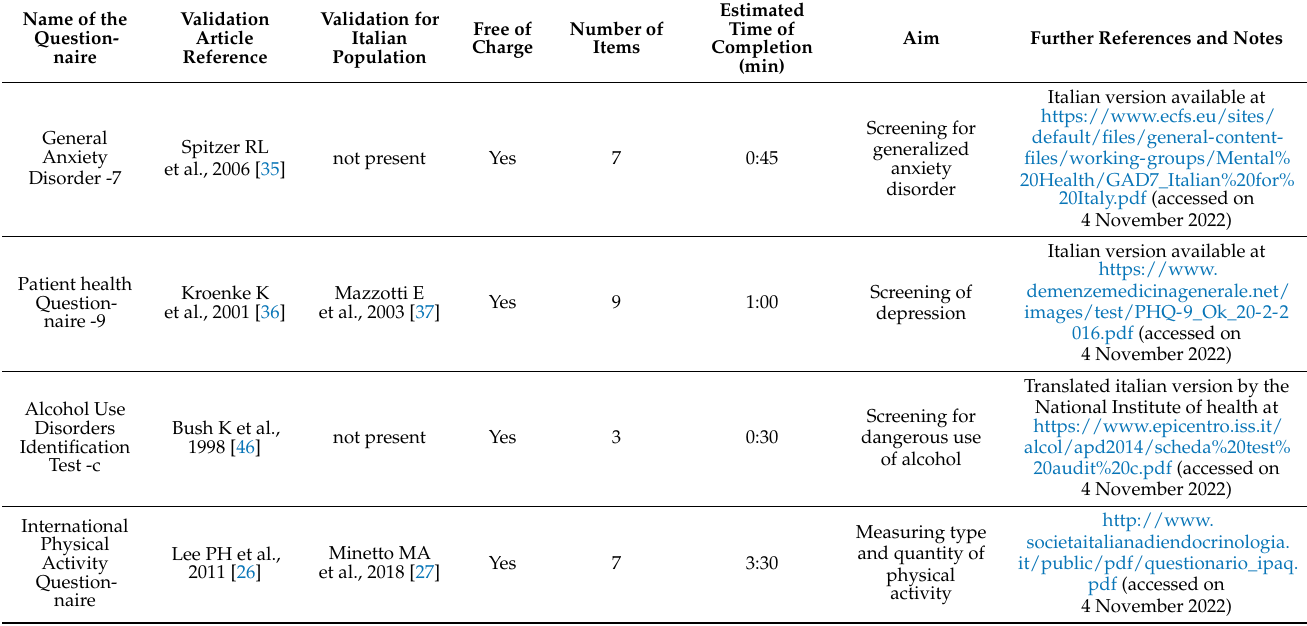
Table 1. Characteristics of the selected tools to include in the final